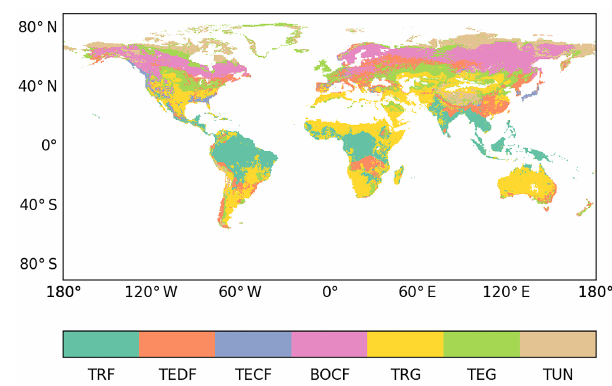
Figure 2. ESA CCI land-cover map classified into the seven large biomes for which average N : C and P : C ratios for each carbon pool are available at a 0 . 25 ◦ × 0 . 25 ◦ resolution: tropical rainforests (TRF), temperate deciduous forests (TEDF), temper- ate coniferous forests (TECF), boreal coniferous forests (BOCF), tropical/C 4 grasslands (TRG), temperate/C 3 grasslands (TEG), and tundra